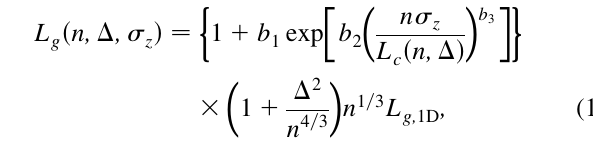
FIG. 2. Normalized gain length L the stretching factor n and the initial normalized energy spread (cid:2) . The black line marks the ideal stretching factor resulting in the shortest gain length for each initial normalized energy spread. Dark red are regions with a normalized gain length of 5 and